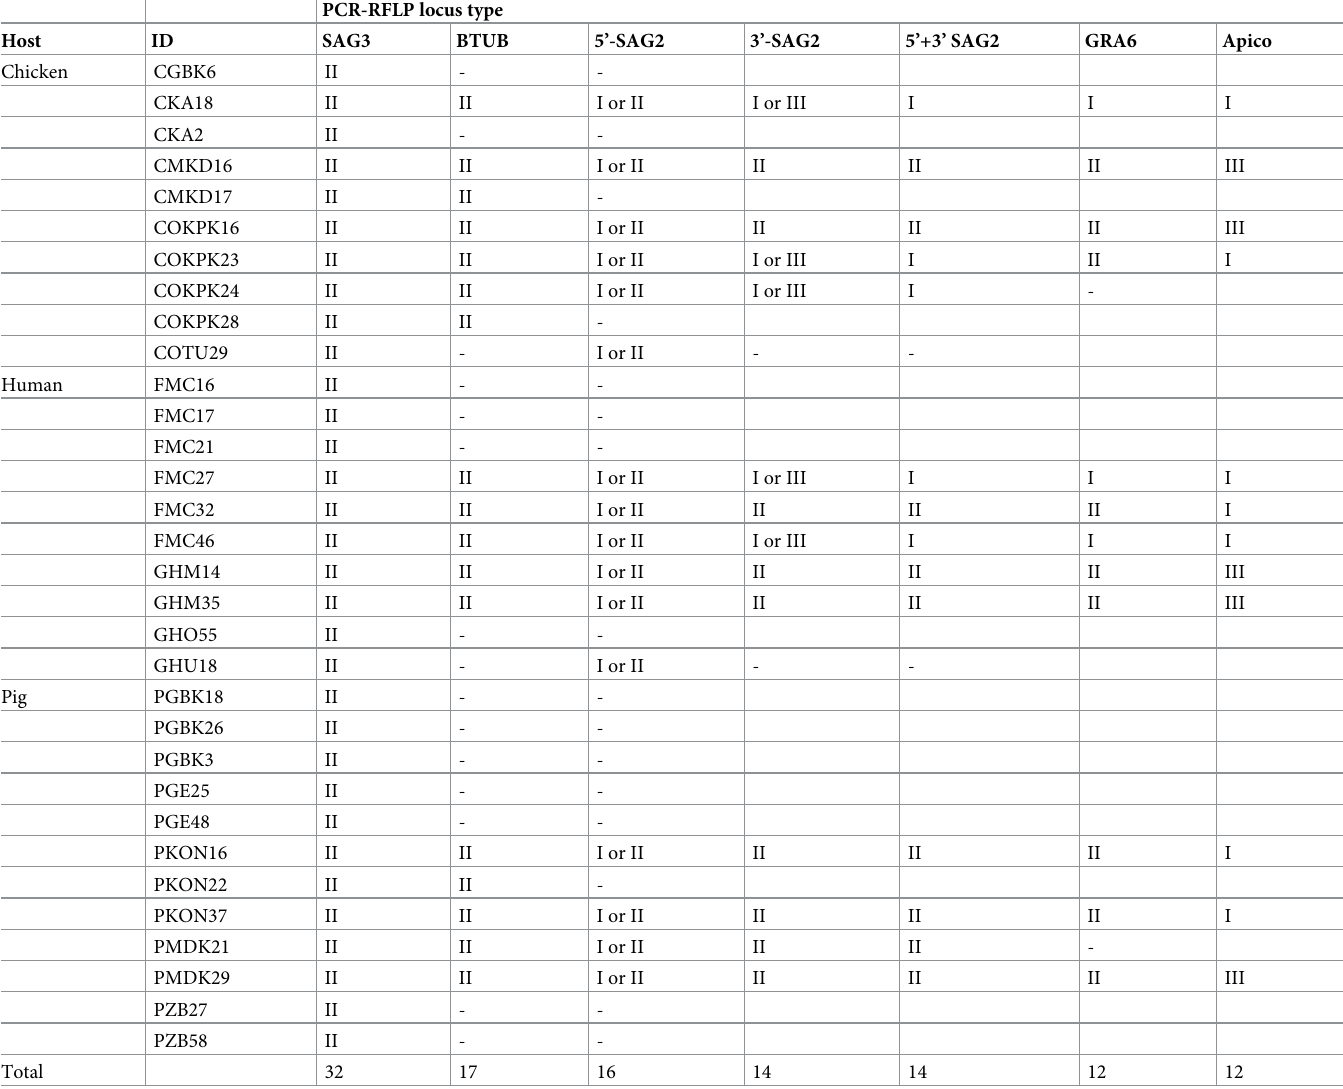
Table 4. Summary of Toxoplasma gondii PCR-RFLP genotyping results from free-range chickens, pigs and seropositive pregnant women sampled in Benue State,